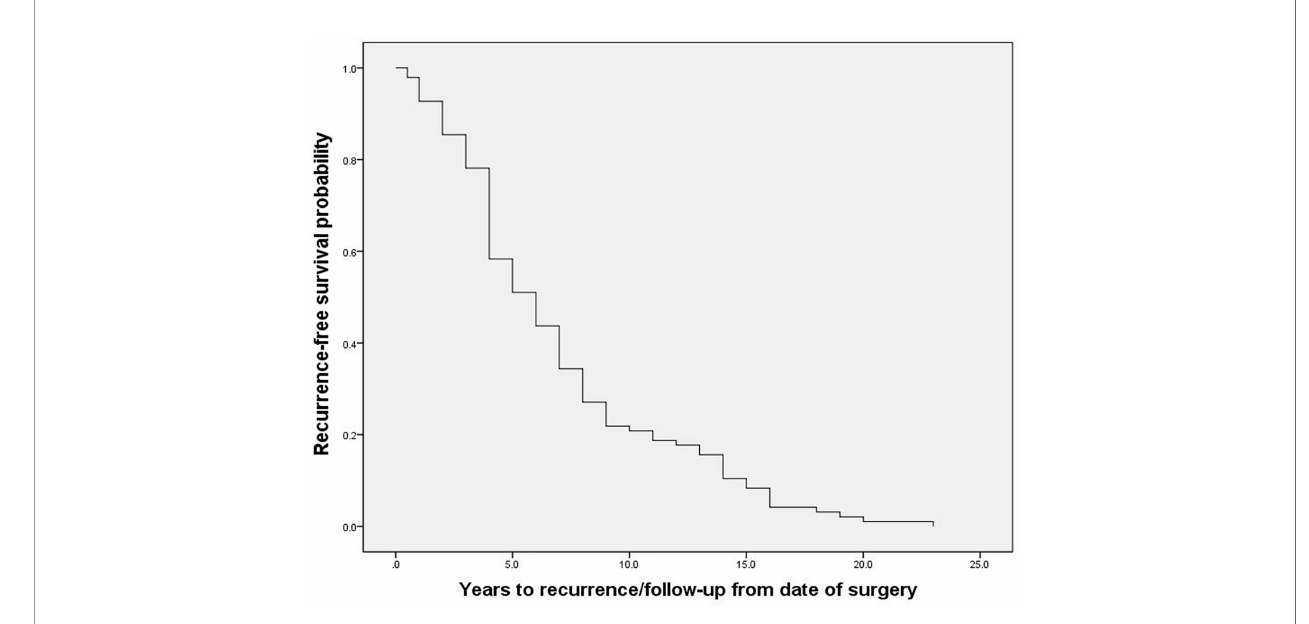
FIGURE 1 | The recurrence-free survival of recurrent patients with pheochromocytoma and